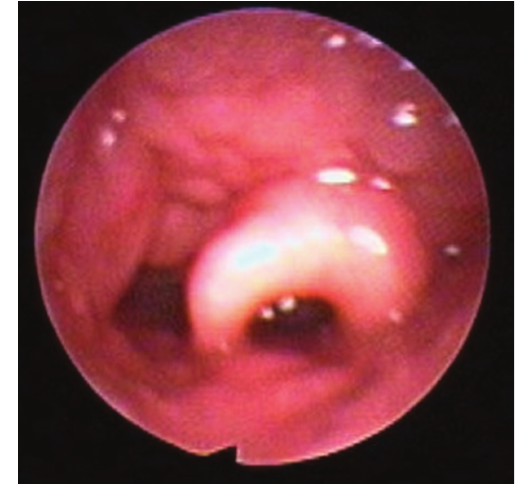
Figure 4: Lymphoid tissue of the lingual tonsils displacing the epiglottis